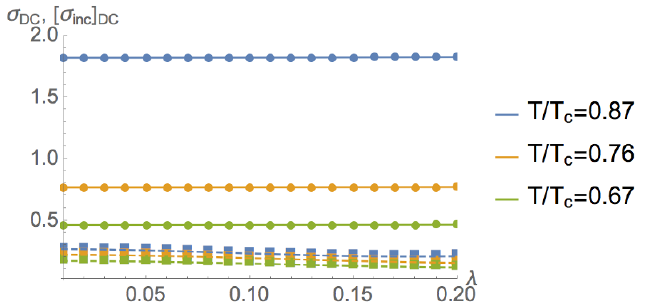
Figure 12 . DC conductivity (circles) and incoherent conductivity (squares) in the pinned sponta- neous case (2.11) as a function of (cid:21) for selected temperatures. We join the data points with a solid and dashed line, respectively, to guide the